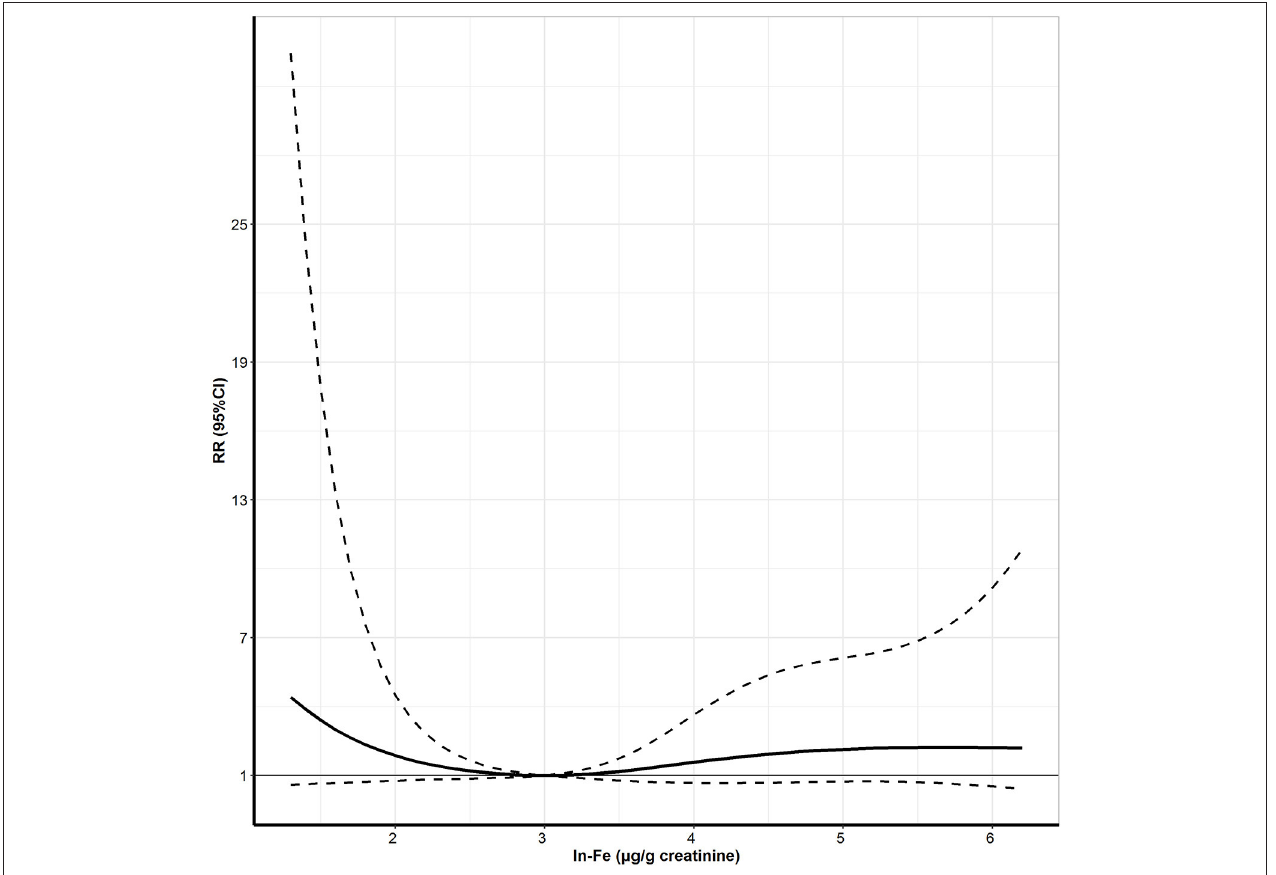
FIGURE 2 | The exposure-response curve between urine Ln-Fe concentration and positive IgG antibody of DENV in pregnant women. Ln- Fe: the urinary Fe concentrations were corrected by creatinine and transformed by natural logarithm. Adjusted for maternal age, maternal education, maternal occupation, yearly income per capita, pre-pregnancy BMI, air-conditioner use, use of mosquito coils, exercise, vitamin consumption, and vegetable consumption.